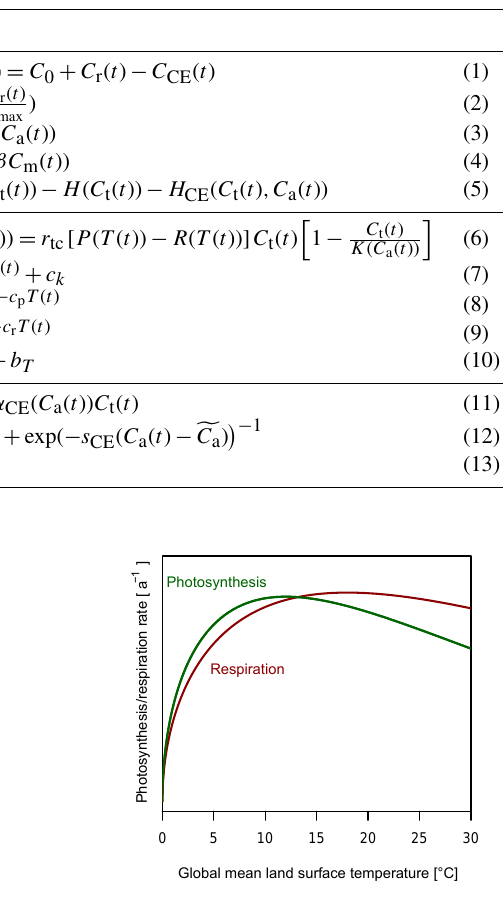
Table 1. Summary of equations describing the co-evolutionary model of societal monitoring and tCDR intervention in the carbon cycle building upon Anderies et al. (2013). The unit a is years.